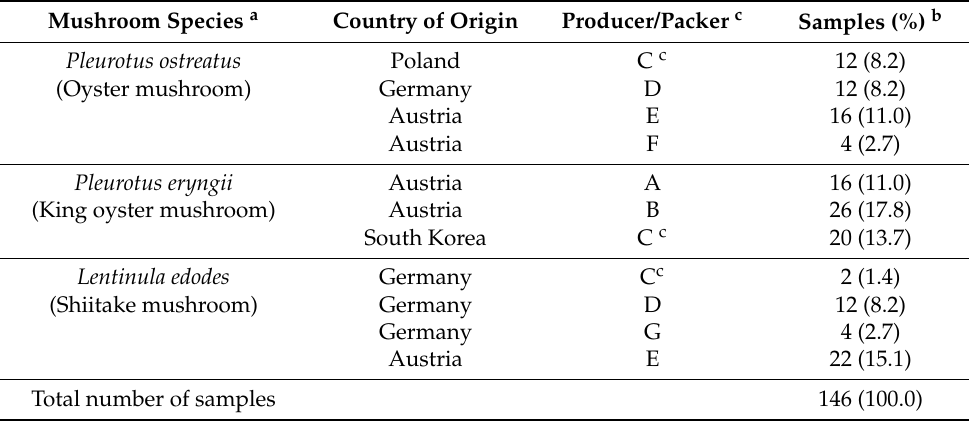
Table 1. Sample description of cultivated mushroom species included in this